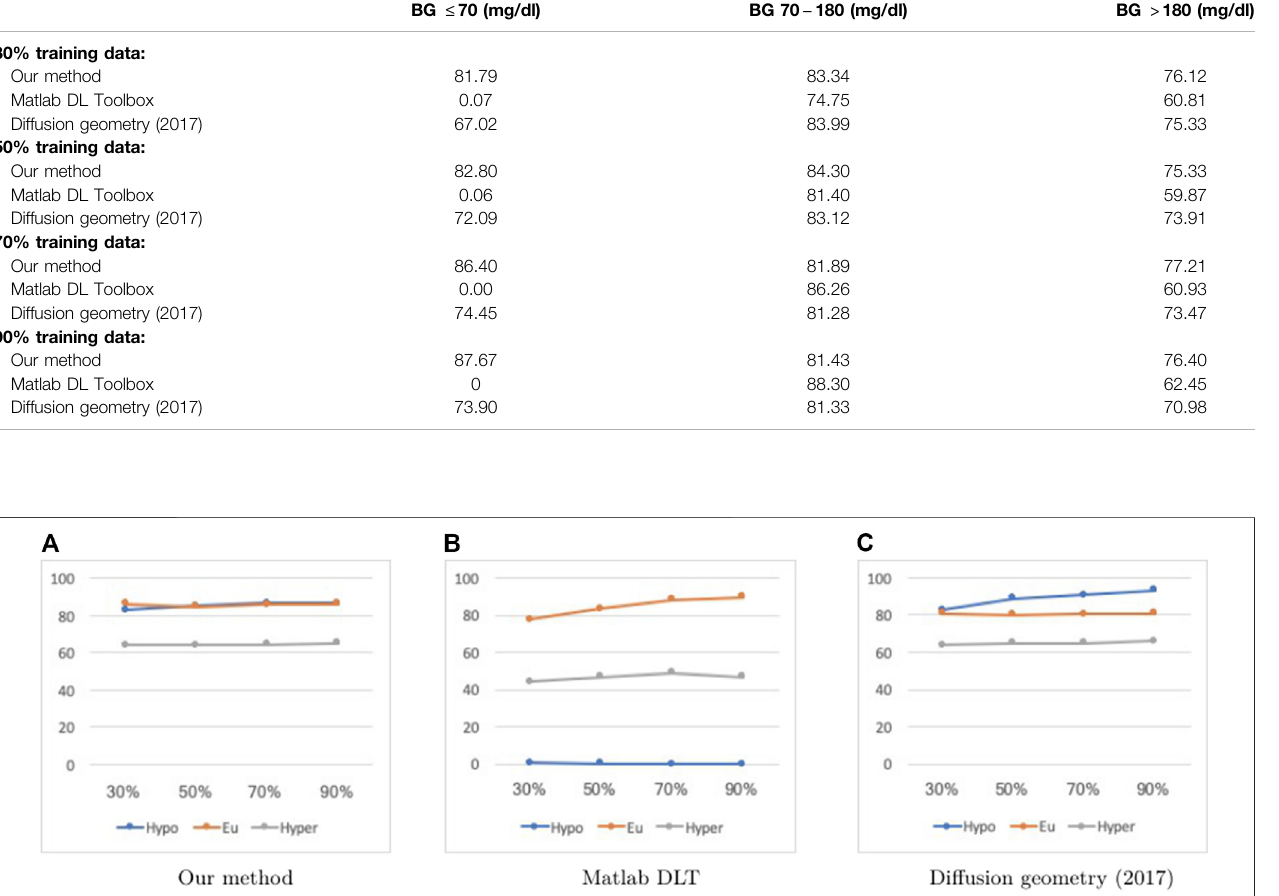
FIGURE 3 | Percentage accurate predictions and predictions with benign consequences in all three BG ranges (blue: hypoglycemia; orange: euglycemia; grey: hyperglycemia) with a 30 min prediction window on dataset D, for different training set sizes (30, 50, 70 and 90%).